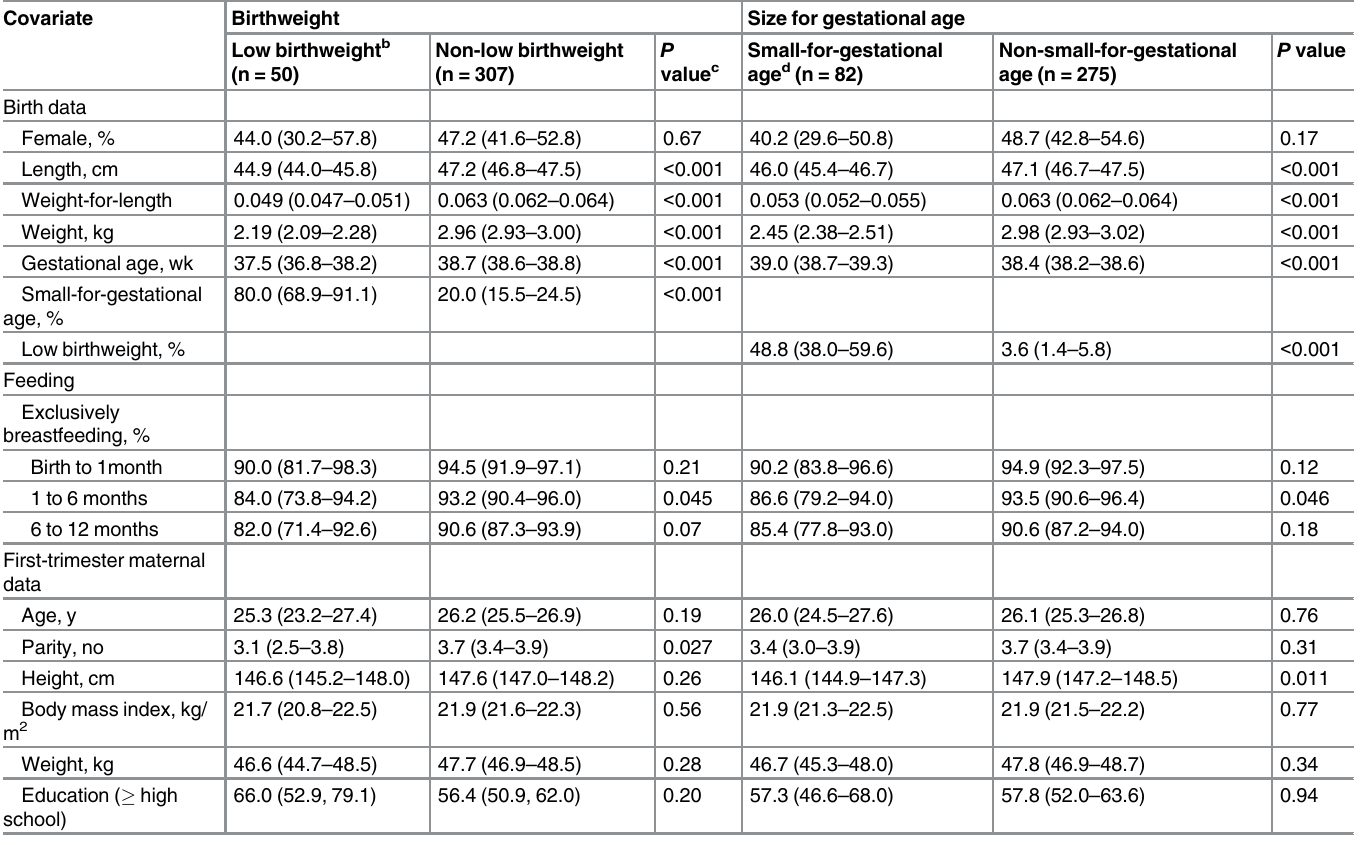
Table 1. Basic descriptive data by birthweight and size for gestational age a